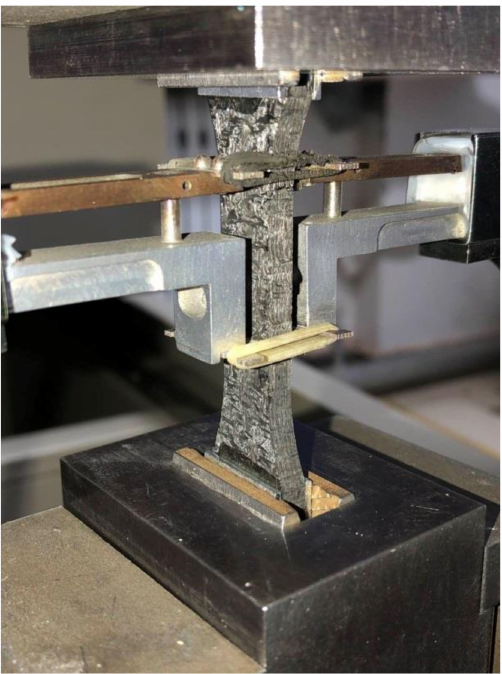
Figure 5. Photograph of tensile specimen and clip-on